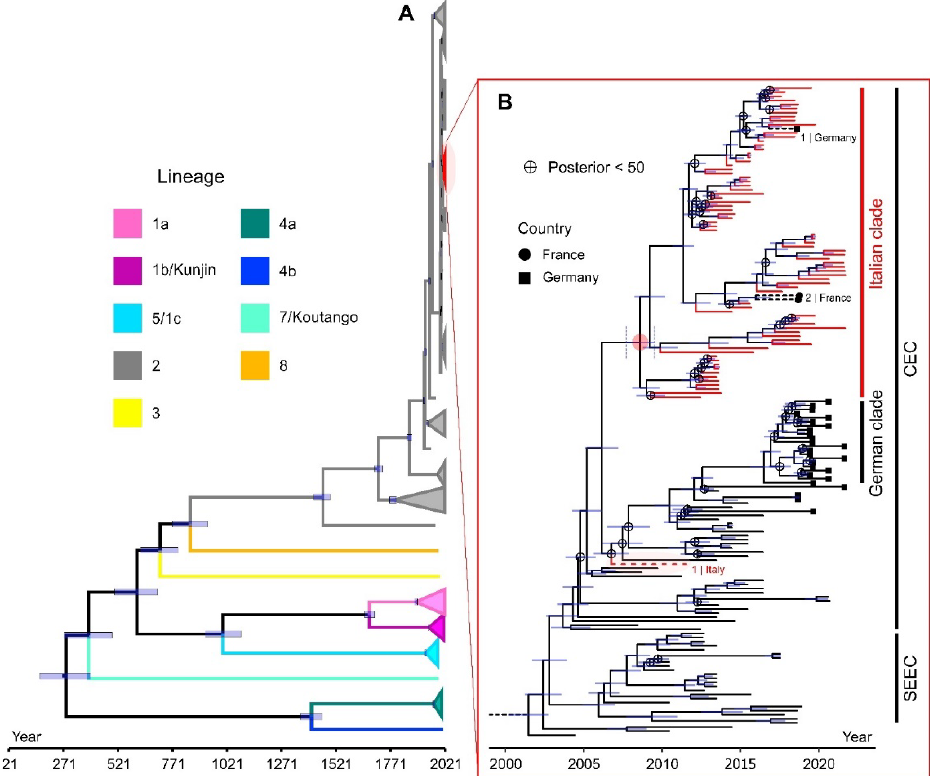
Figure 3. ( A ) Worldwide time tree of 368 WNV genome sequences from 44 different countries. WNV lineages are indicated with different colours. Uncertain dates are represented with blue bars showing the 95% HPDs. Nodes defining the major lineages have all posteriors >70 (in most cases >90). A clade which includes the majority of the WNV L2 sequences from Italy is highlighted in red, inside the general WNV L2 subtree (in grey). ( B ) A magnification of the tree, showing the position of the Italian clade of WNV L2 among the central European clade (CEC). A WNV L2 genome sampled in Italy (JN858070.1, sampled in 2011 in the city of Ancona) and not belonging to the identified clade is shown with a red dotted line. The south-eastern European clade (SEEC), sister of the CEC, is also shown in the tree. Nodes with posterior probability <50 are indicated with a circled cross.